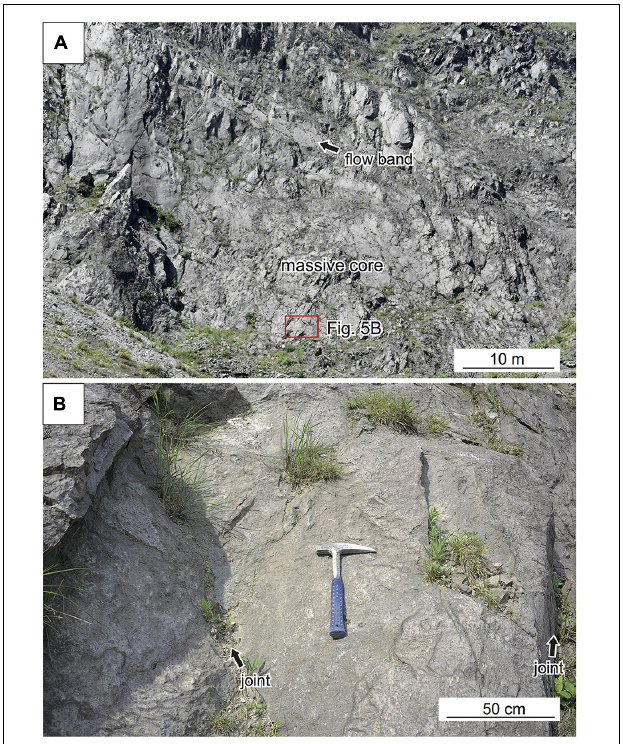
FIGURE 5 | (A) Photograph of the massive core of the Ogariyama dome. The location of (B) is indicated by the red rectangle. (B) Close-up view of the massive core of uniform rhyodacite. The hammer is 33 cm